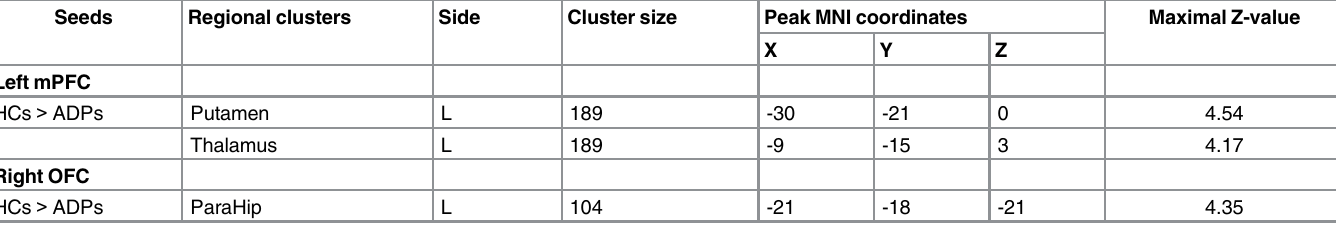
Note: mPFC, medial prefrontal cortex; OFC, orbitofrontal cortex; ParaHip, parahippocampal gyrus; ADPs, alcohol dependent patients; HCs, healthy controls; R = Right; L = left; MNI: Montreal Neurological